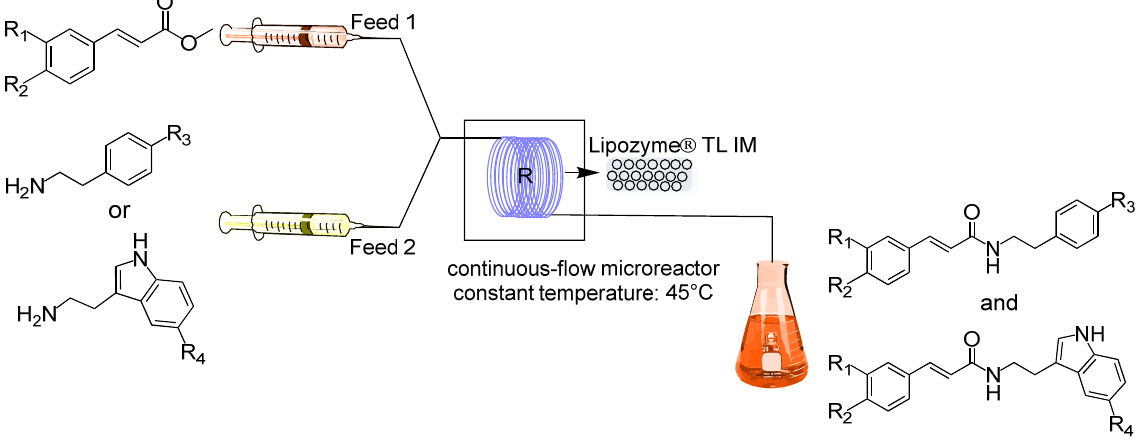
Figure 6. Equipment for the synthesis of cinnamamides from methyl cinnamates and phenylethyl- amines catalyzed by Lipozyme ® TL IM under continuous-flow microreactors.